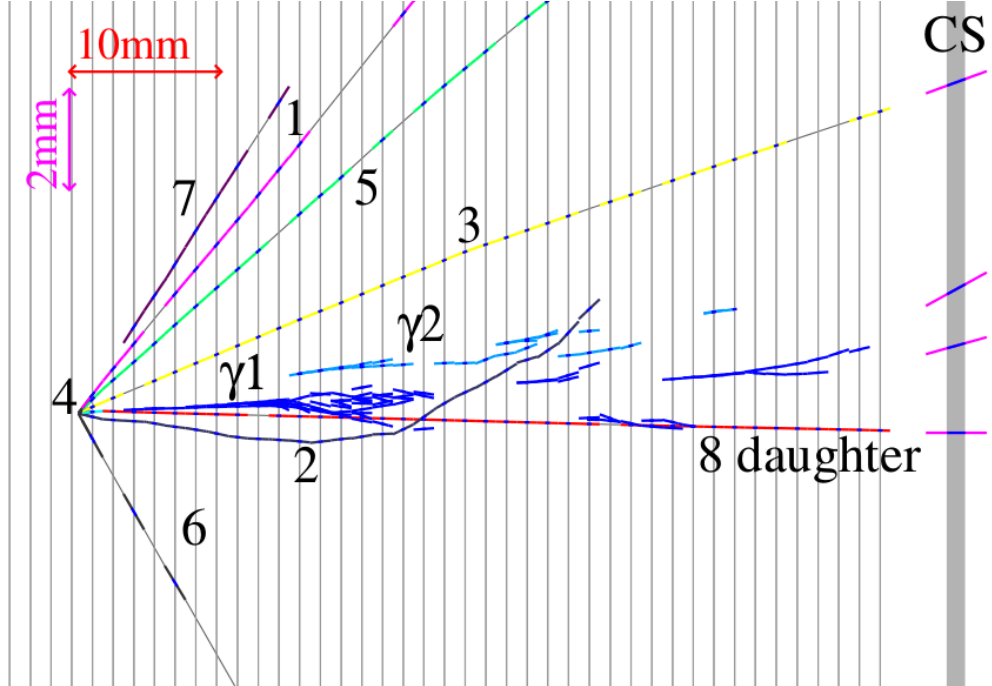
Figure 1. The first τ candidate observed by OPERA. The candidate, visible as a small cyan-colored track connected to the interaction vertex and labeled with 4, undergoes a decay, within 1 mm, into a charged pion, colored in red and labeled with 8, and two γ , whose invariant mass is compatible with that of a π 0 . The charged particles in the event, are composed by aligned track segments reconstructed in consecutive emulsion layers.